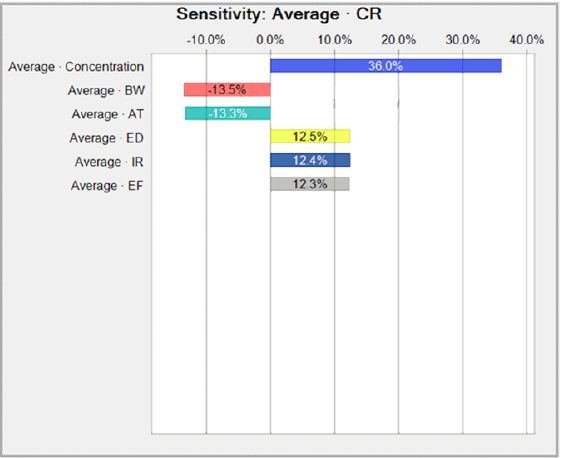
Figure A3. SA of LTCR model (adults) for Pb in water.